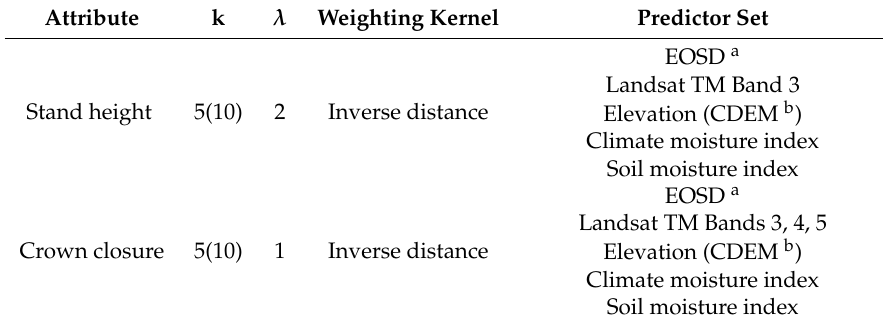
Table 6. Finalized k-NN model parameters for stand height and crown closure, derived from initial optimal parameters. Bracketed values of k are those deemed optimal, prior to 5% mean squared error adjustment. Note, λ refers to the Minkowski distance parameter (Equation (3)).